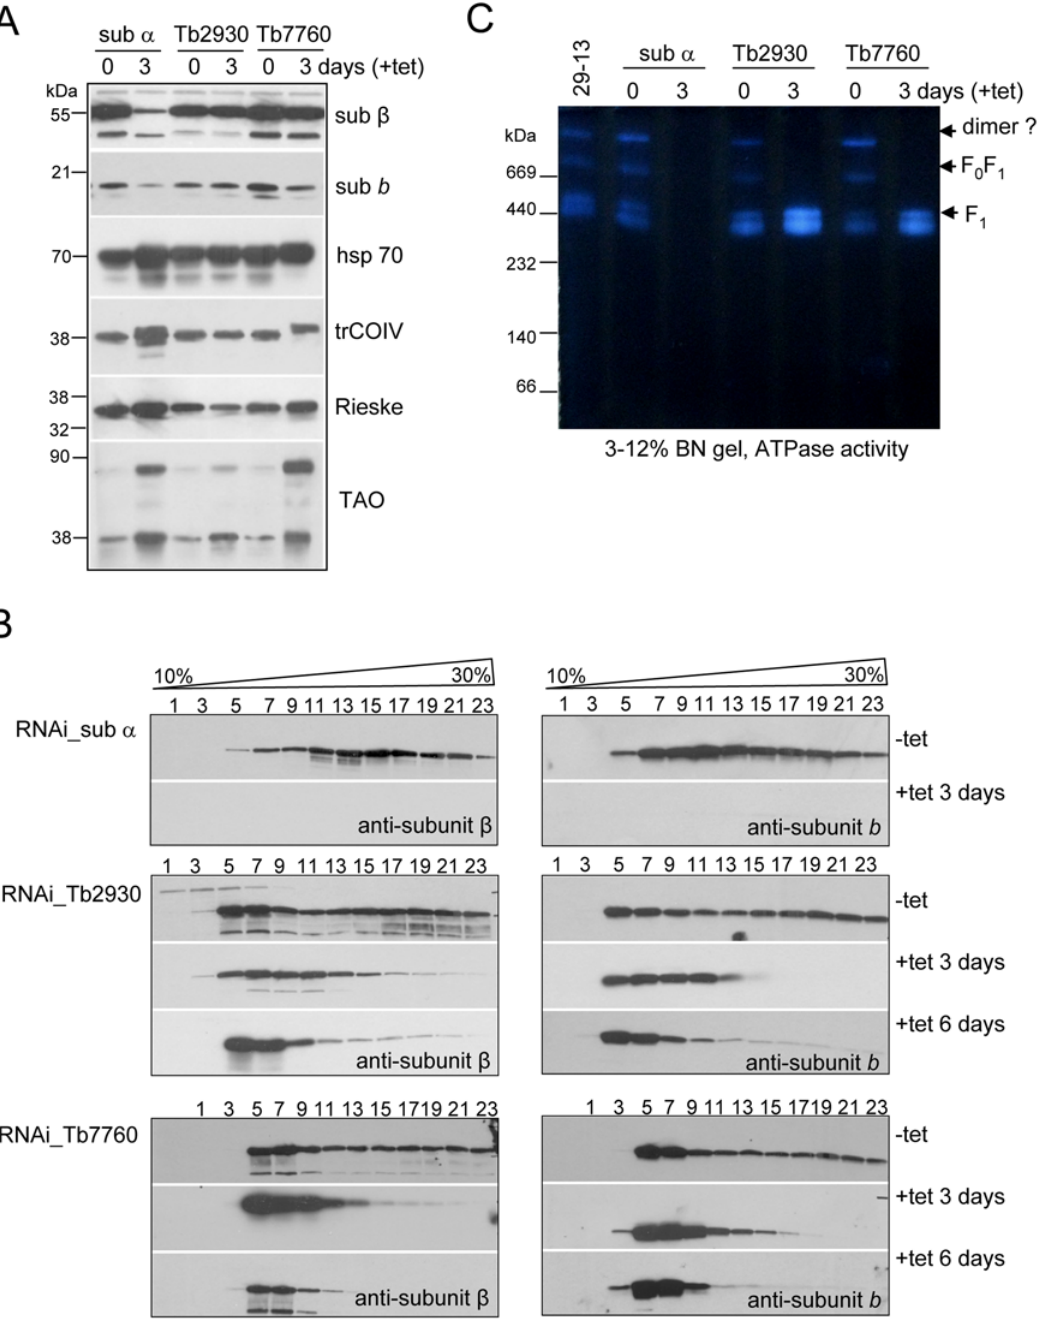
Figure 5. Effect of RNAi silencing of subunits a , Tb7760 or Tb2930 on steady-state abundance and integrity of F 0 F 1 -ATP synthase complex. (A) The steady state abundance of examined proteins was analyzed by Western analysis of lysed crude mitochondria (7.5 m g of proteins per well) prepared from RNAi-induced cells after 3 days and from uninduced control cells. The blots were probed with antibodies against subunits b , b , trCOIV, Rieske protein, mt alternative oxidase (TAO) and mt hsp 70 as a loading control. (B) Western analyses of glycerol gradient fractions (numbered from top to bottom) from crude mitochondrial lysate of RNAi cell lines grown in the absence ( 2 tet) or presence ( + tet) of tetracycline for 3 and 6 days are shown. (C) In-gel ATP hydrolysis activity of T. brucei F 0 F 1 -ATP synthase complexes after ablation of subunit a , Tb7760 or Tb2930. Mitochondrial preparations were solubilized using dodecyl maltoside and separated by 3–12% BN PAGE. In-gel ATP hydrolysis/lead phosphate precipitation assay revealed bands representing putative monomeric and dimeric ATP synthase complexes and free F 1 particles. The sizes of the native high molecular weight marker (Amersham) are indicated. doi:10.1371/journal.ppat.1000436.g005 These observed results are intriguing because it has been crucial for procyclic cell survival. This was concluded from the proposed that, under the growth conditions used in our RNAi observations that in the presence of glucose these cells are 1000- studies (i.e. 6 mM glucose), the function of ATP synthase is not times less sensitive to the ATP synthase inhibitor oligomycin than